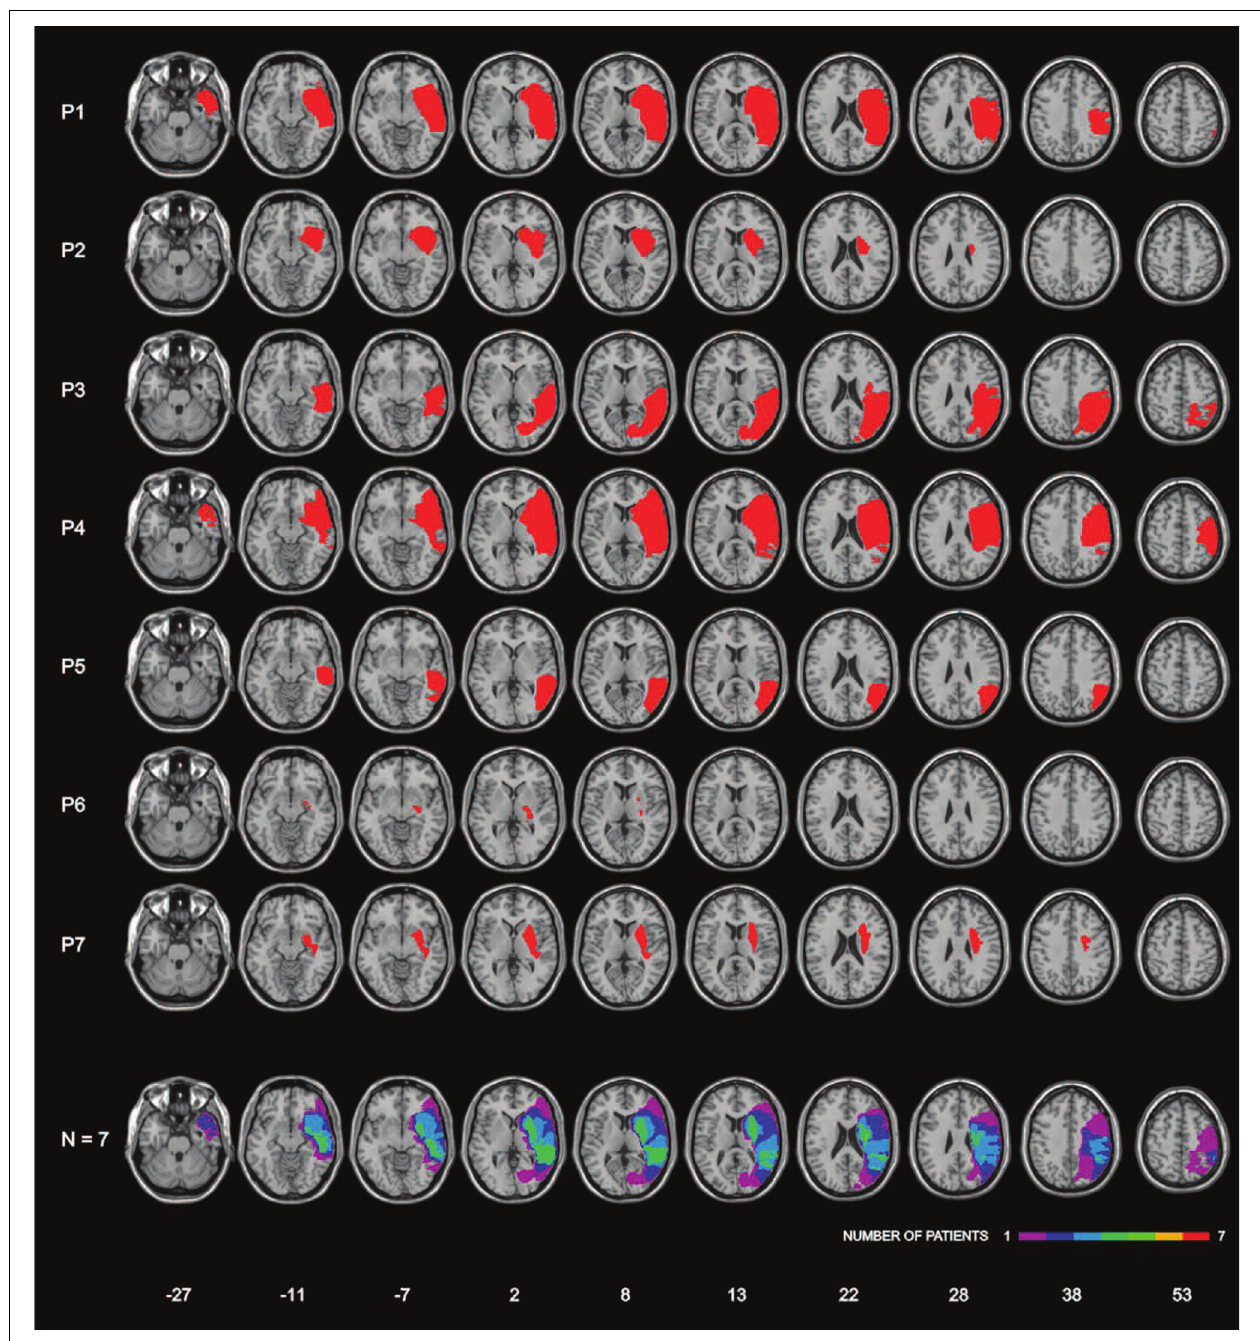
FIGURE 1 | Lesion localization in seven right-hemisphere-damaged patients with right-hemispheric lesions, and lesion overlap. Bottom row: frequencies of